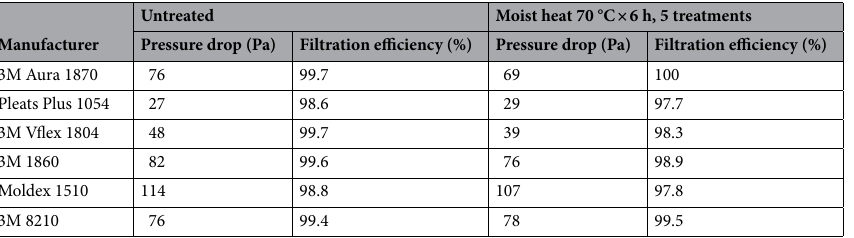
Table 3. Filtration efficiency testing results of N95 respirators after repeat decontamination cycles. A single respirator of each type was used for filtration testing following it’s use in fit